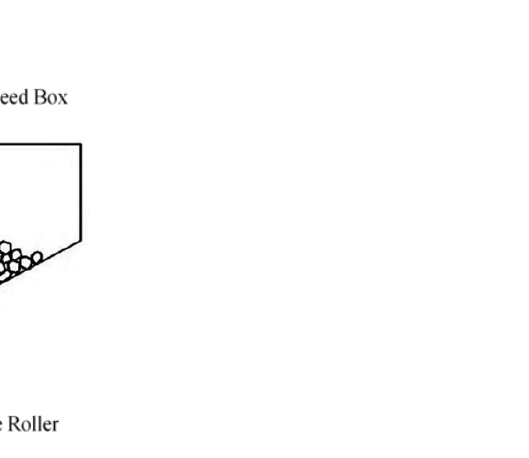
Figure 5. Cup-type seed metering device. Reprinted with permission from ref. [19]. Copyright 2016 Chinese Heilongjiang Agricultural Commission.